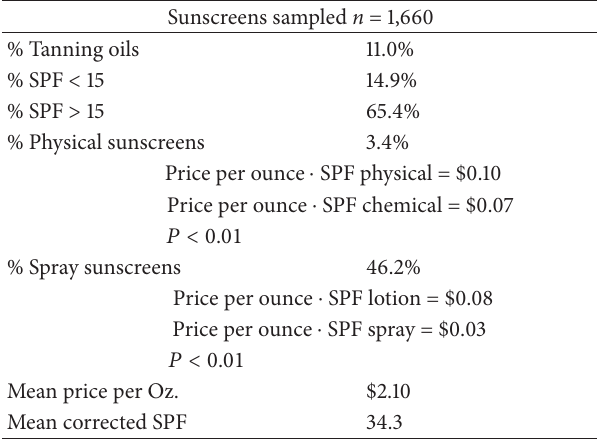
Table 3: Makeup of the sampled sunscreen isles with comparisons between the price per ounce, corrected for SPF, of physical versus chemical sunscreens and spray versus lotion